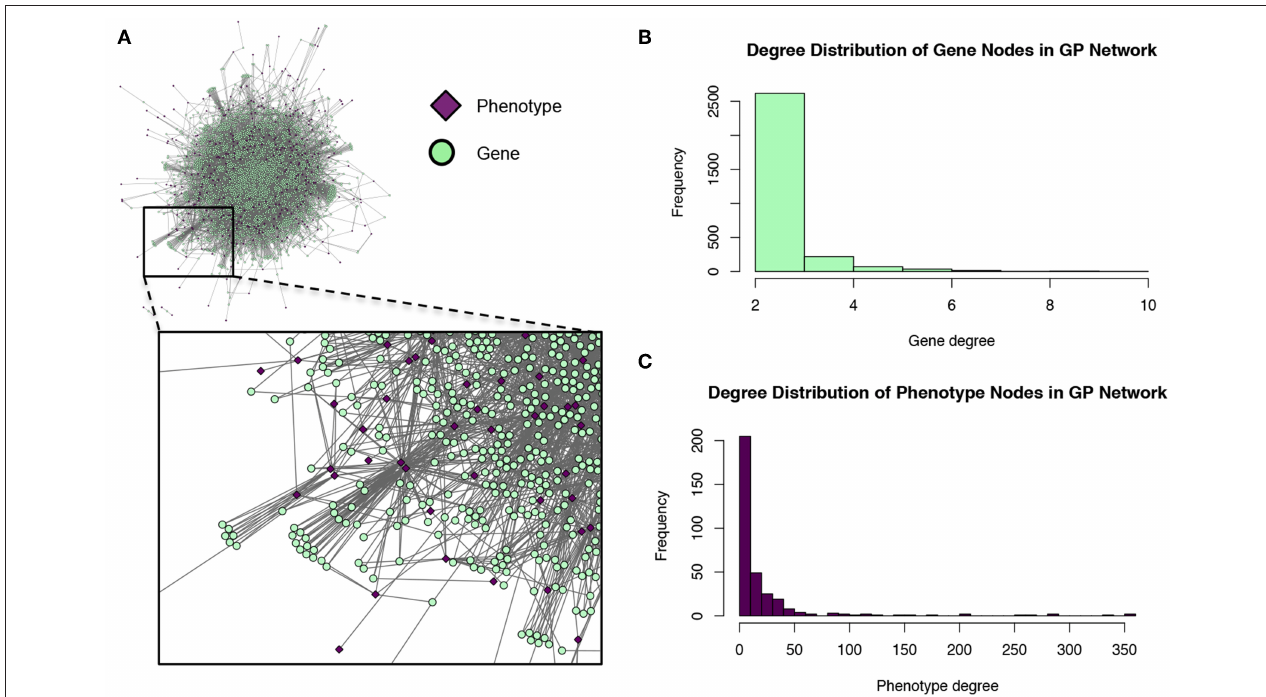
FIGURE 7 | Gene-phenotype ( GP ) network. (A) The GP network. Green nodes represent MPA genes, pink diamonds represent metabolites (phenotypes). An edge connects a gene to a phenotype if that gene contains a SNP associated with that phenotype. (B) Degree distribution of the gene (green) nodes in the GP network. (C) Degree distribution of the phenotype (pink) nodes in the GP